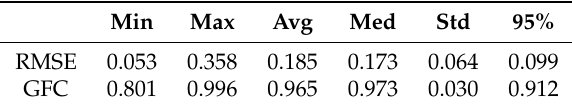
Table 3. Minimum, maximum, average, standard deviation and 95 percentile values for both root mean square error and goodness of fit coefficient. Small root mean square error corresponds to desired value and close to one corresponds to a desired goodness of fit coefficient